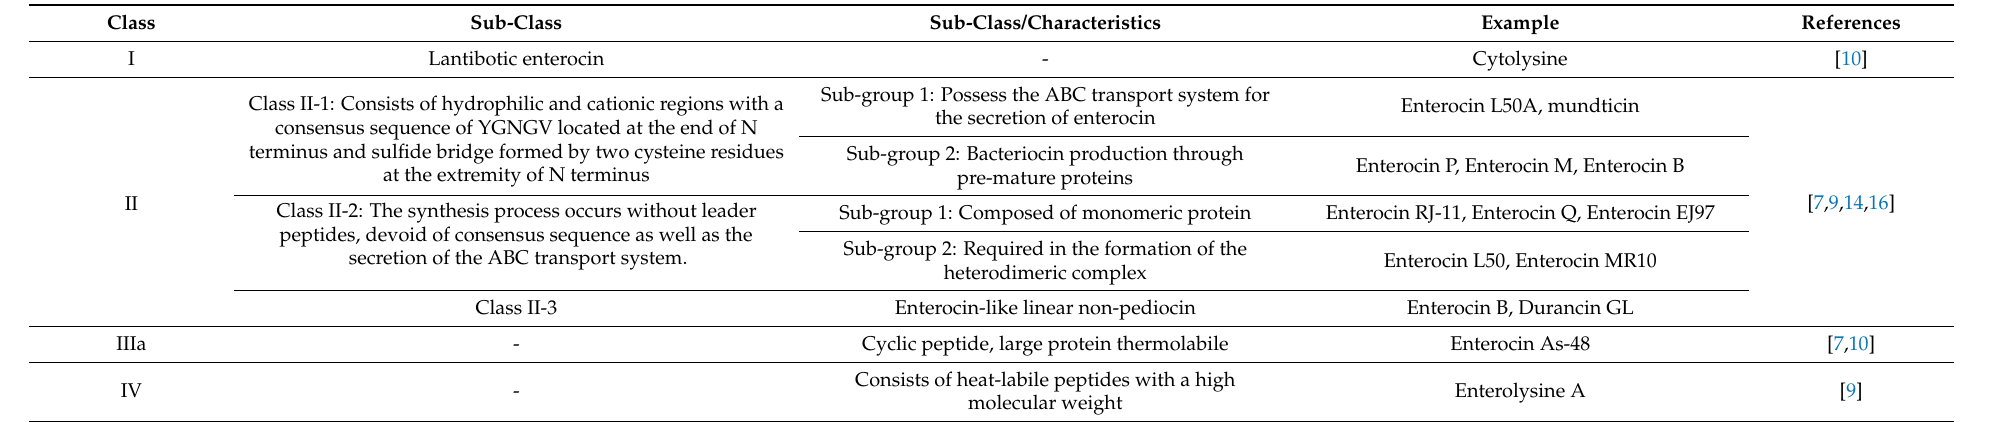
Table 1. Enterocin